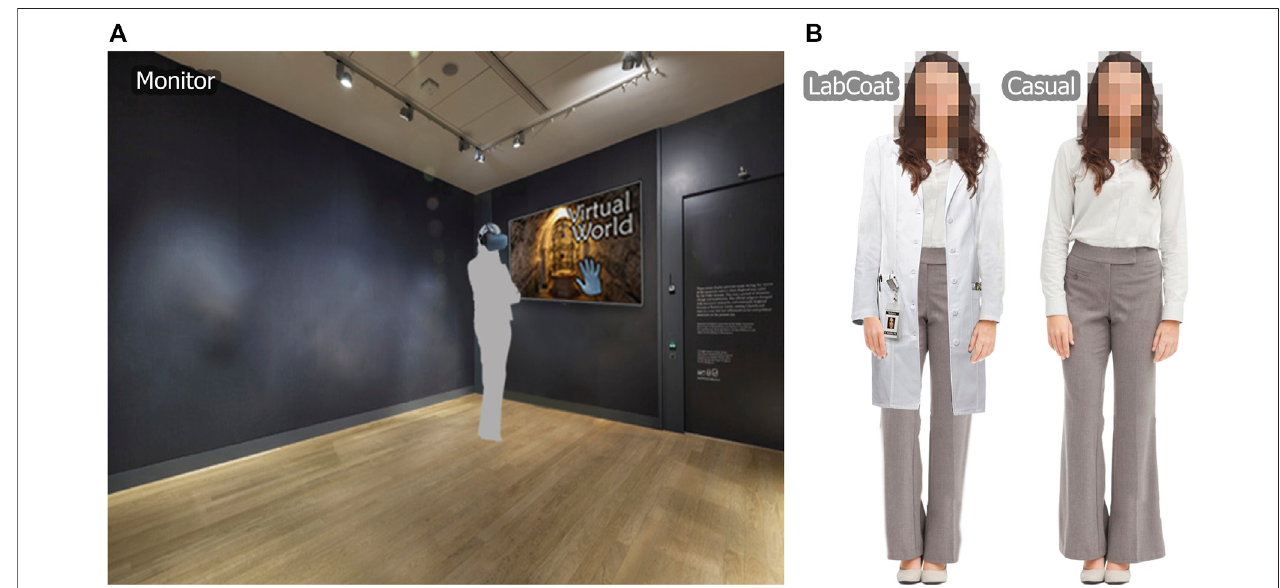
FIGURE2| AnillustrationoftheimageusedintheMonitorcondition (A) andtheimagesusedintheLab-coatversusCasualcondition (B) .Notethatthefacesinthe image have been obscured above (they were not obscured during the study).